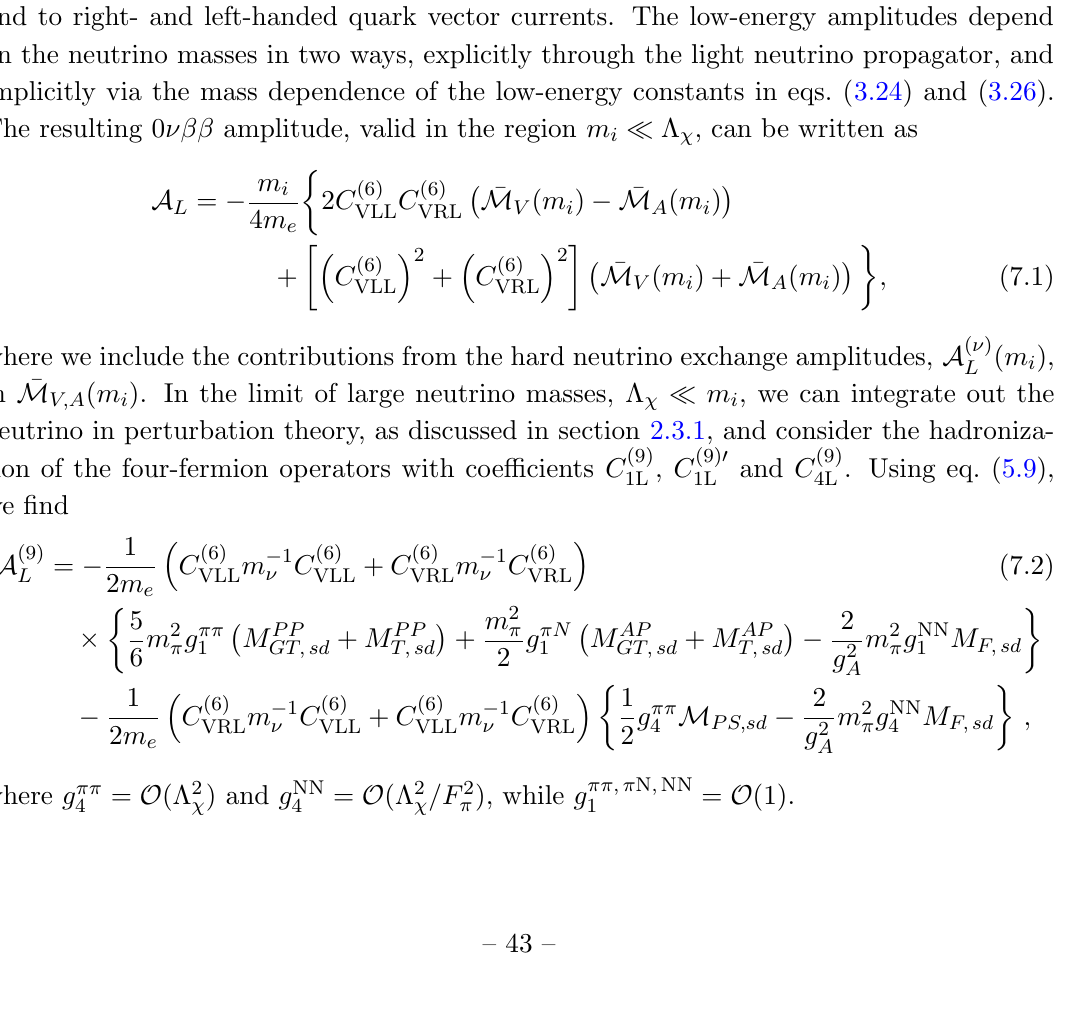
(cid:16) (cid:17) n @ (cid:2) O (9) , cannot be neglected as they induce corrections (cid:24) ((cid:3) m i